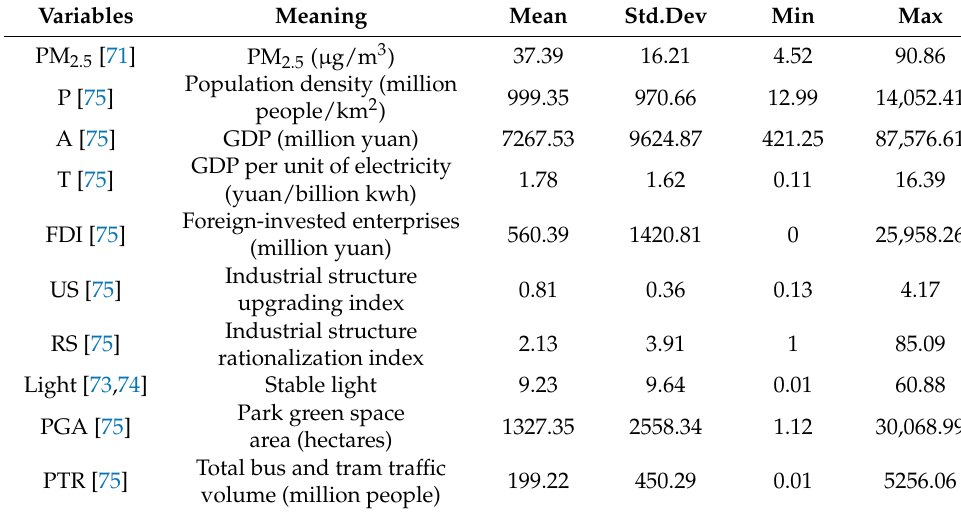
Table 2. Variables in the empirical model.